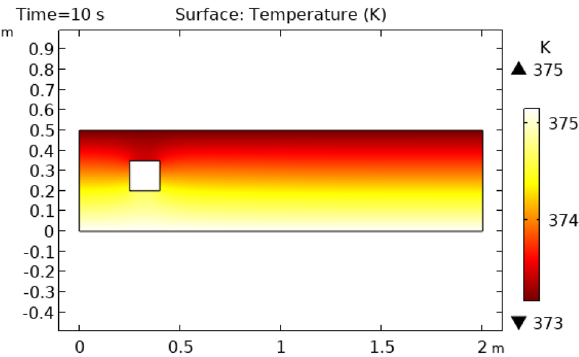
Figure 13. Surface Temperature in squared cylindrical flow at t = 10 s.